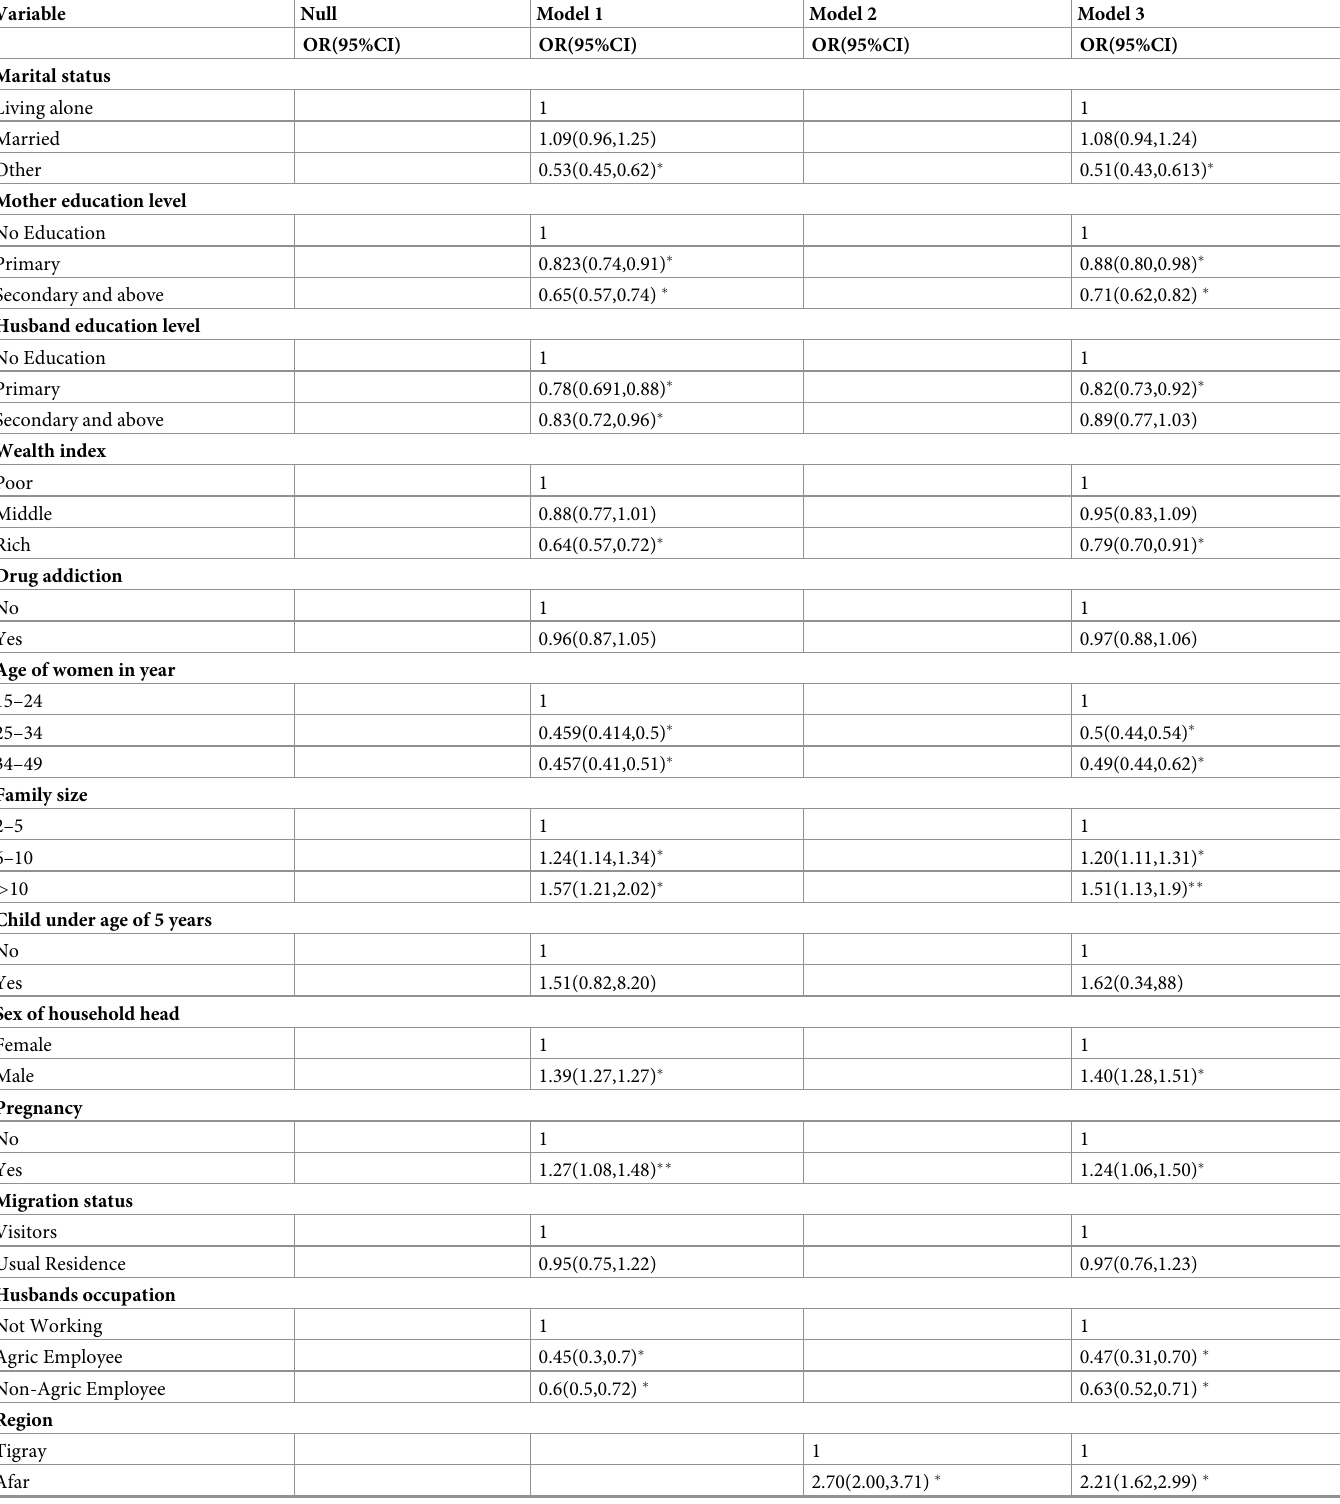
Table 2. Factors associated with women unemployment in Ethiopia, EDHS